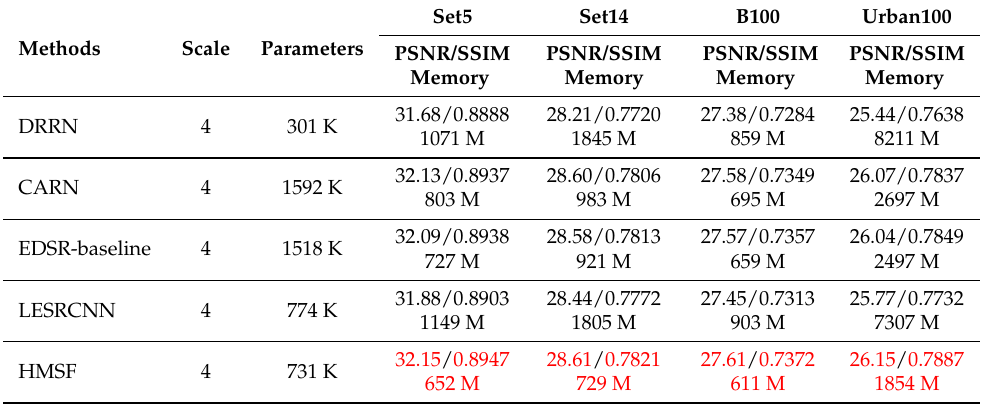
Figure 12. Visual qualitative comparisons on 4 × scale datasets. Table 9. Using memory consumption as the evaluation criterion—in a comparison of five open-source methods with 4 × scale—our method has the best performance and smallest memory consumption. Red text means the best